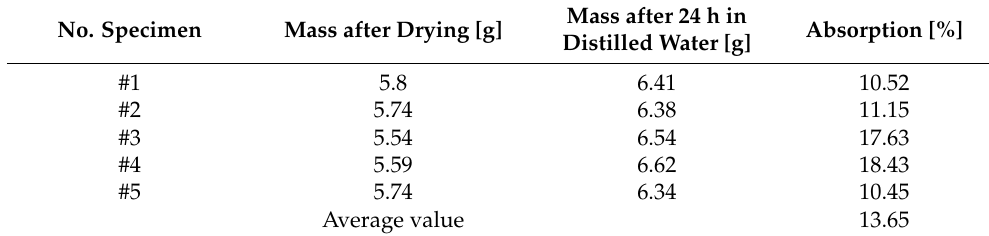
Table 8. Cooling oil absorption of Ecoflex 00-10 test